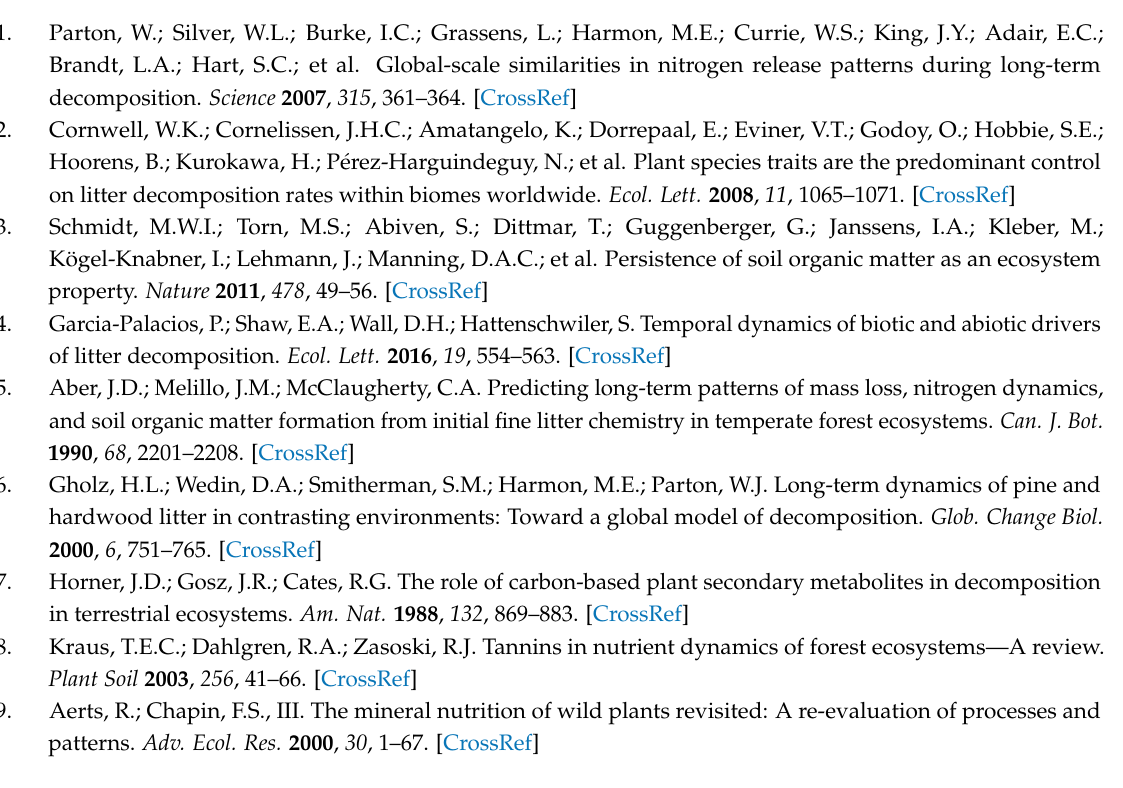
Table S1: Temperature ( ◦ C) and total precipitation (mm) for the growth periods (GP, mid-May to mid-October) and non-growth periods (NGP, mid-October to mid-May), as well as annual for the different years. Table S2: Total N and C concentrations (mg/g dw) and C/N ratios in two consecutive years in leaf litter and green leaves. Table S3: Total soluble amino acid, protein, and phenolic concentrations (mg/g dw) in two consecutive years in leaf litter and green leaves. Table S4: Principal Component Analysis—Loading for the measured